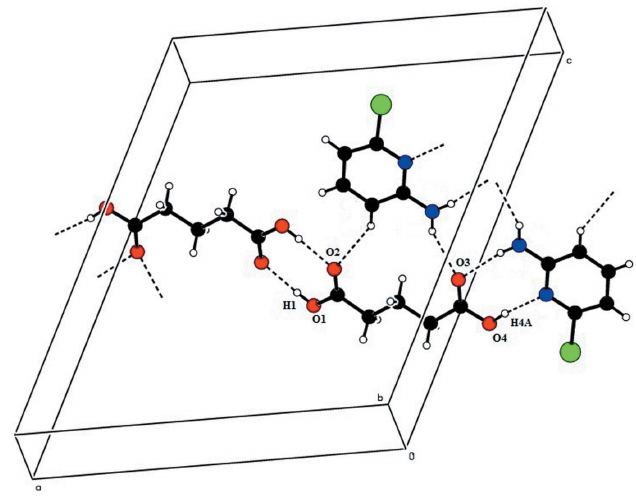
Figure 2 A packing view of the title compound, showing the sheet structure formed by O—H (cid:2)(cid:2)(cid:2) O, O—H (cid:2)(cid:2)(cid:2) N, N—H (cid:2)(cid:2)(cid:2) O and C—H (cid:2)(cid:2)(cid:2) O hydrogen bonds (dashed lines).